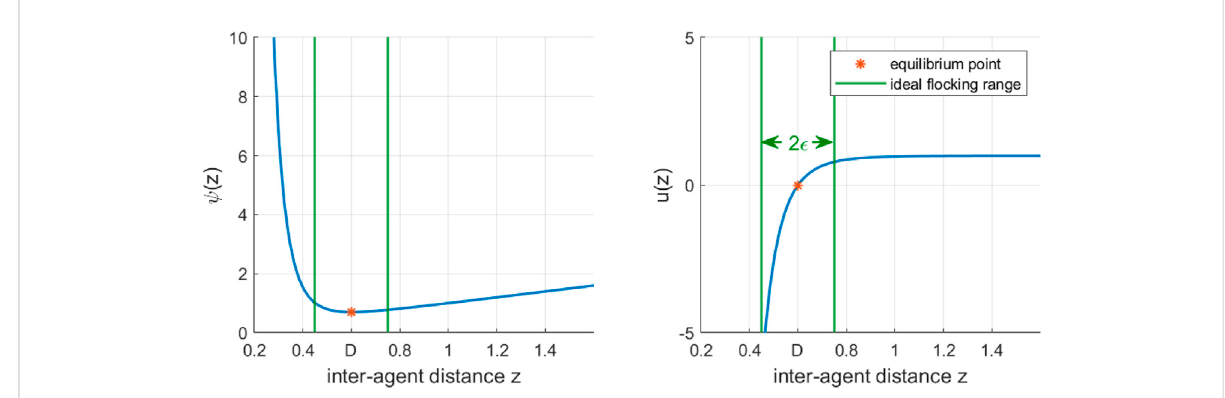
FIGURE 1 Potential (left) and action function (right) used in this work, with a desired inter-robot distance D (cid:2) 0 . 6 m. The zone between the green lines is considered the “ ideal range ” (width of 2 ϵ ) considered in the spatial discretization described in Section